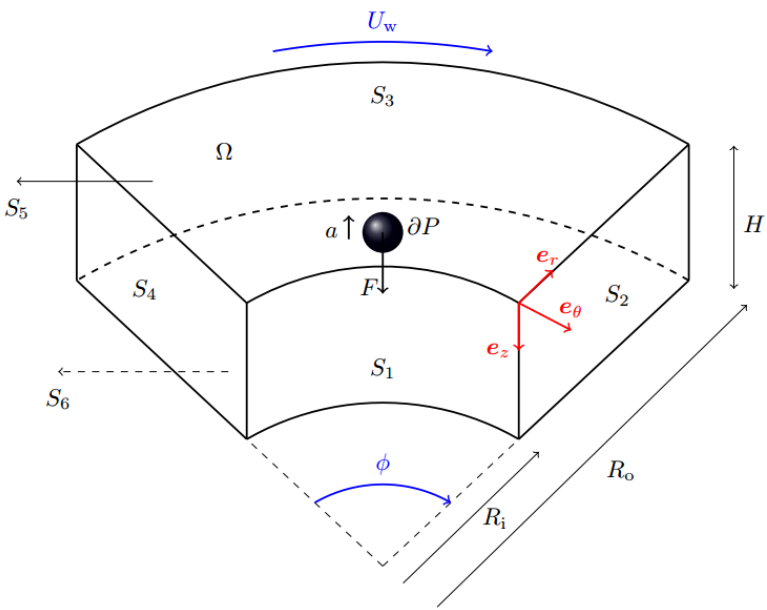
Figure 1. Problem description of a rigid, spherical particle suspended in a viscoelastic Couette flow. The Couette flow is set up by moving the outer cylinder in the tangential direction, with velocity U w , while the inner cylinder remains stationary. Simultaneously, a force acts on the particle in the z -direction, causing it to sediment. The inner cylinder boundary is denoted by S 1 , the outer cylinder boundary is denoted by S 3 . The top and bottom of the Couette are denoted by S 5 and S 6 , respectively. The periodic side boundaries are denoted by S 2 and S 4 , where S 4 is rotated over an angle φ with respect to surface S 2